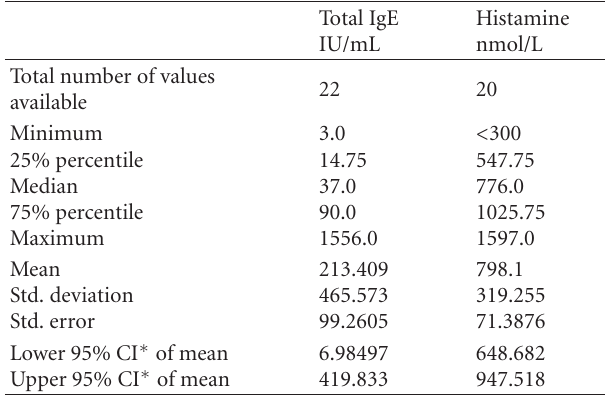
∗ CI: confidence interval. Table 5: Summary of serum IgE levels and whole blood histamine levels.